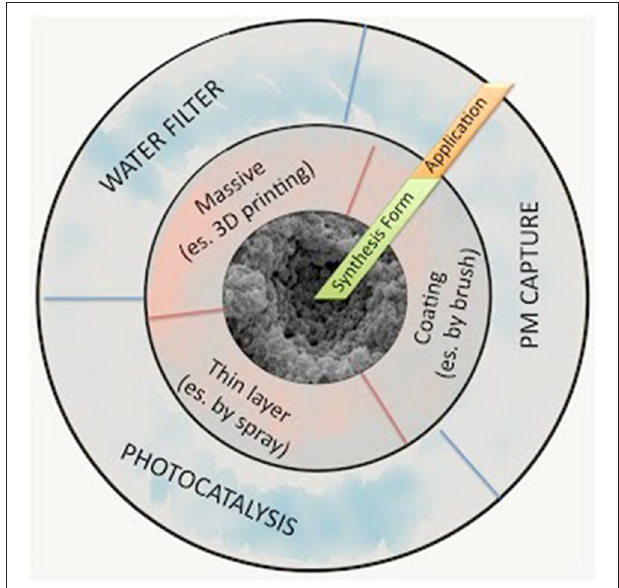
FIGURE 1 | Possible SUNSPACE applications, based on the selected synthesis form (massive, coating, thin